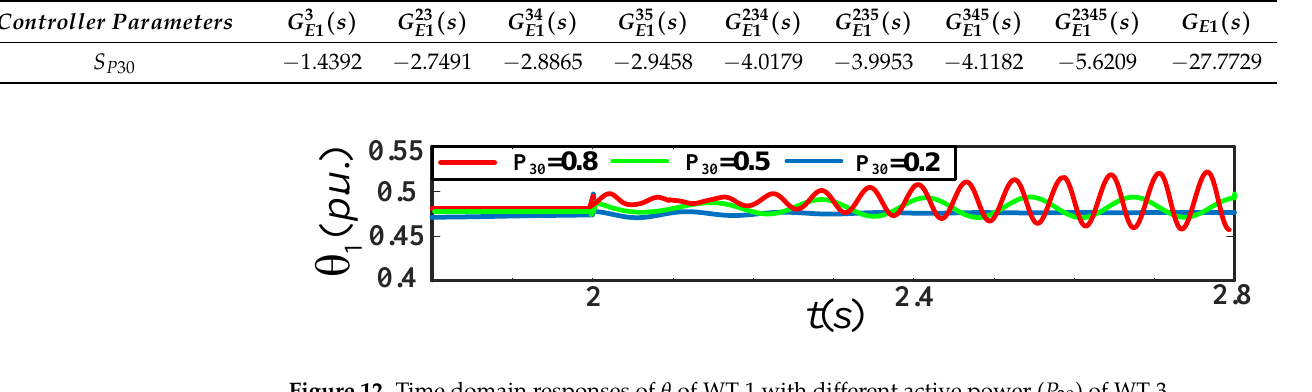
Figure 12. Time domain responses of θ of WT 1 with different active power ( P 30 ) of WT